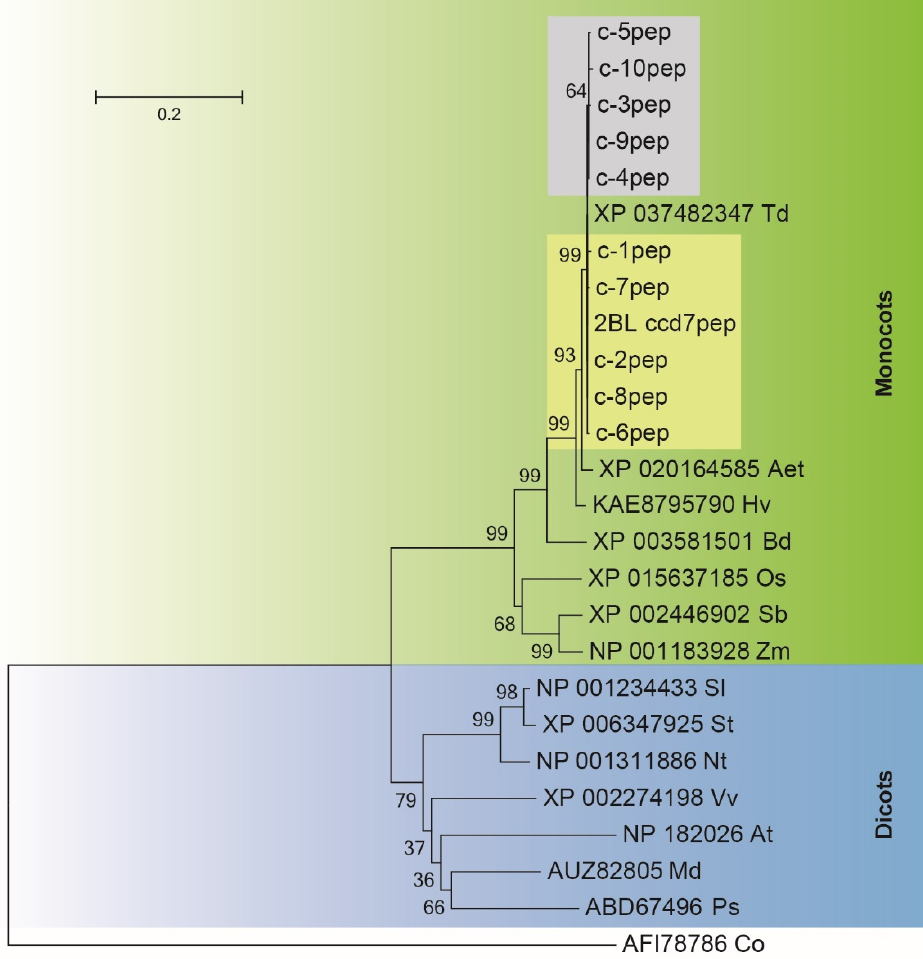
Figure 3. Phylogenetic analysis of CCD7 proteins in different monocots and dicots. The deduced amino acid sequences of CCD7 were aligned using the ClustalW (www.ebi.ac.uk/clustalw, accessed on 10 December 2021) online program. The phylogenetic tree was constructed using MEGA7 by the neighbor joining (NJ) method, with 1000 bootstrap replicates. The tree clusters in two groups, demarcated by green and blue areas, into monocots and dicots, respectively. The grey and yellow squares indicate the two sub ‐ classes of wheat CCD7 ‐ B proteins. Co , Coleochaete orbicularis.